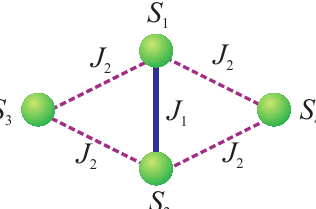
Figure 1. A schematic illustration of the spin-1 Heisenberg diamond cluster, which involves two different exchange interactions J 1 and J 2 along a shorter diagonal and sides of a diamond spin cluster depicted by thick solid and thin broken lines,